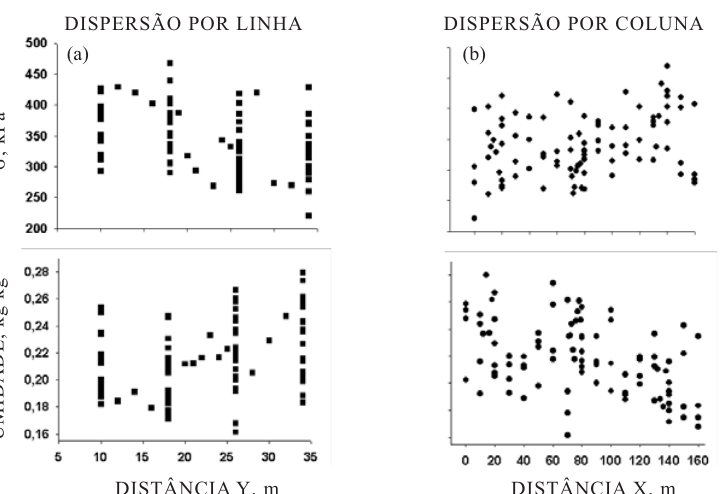
Figura 4. Gráficos de dispersão dos dados de pressão de preconsolidação ( σσσσσ (a) e coluna